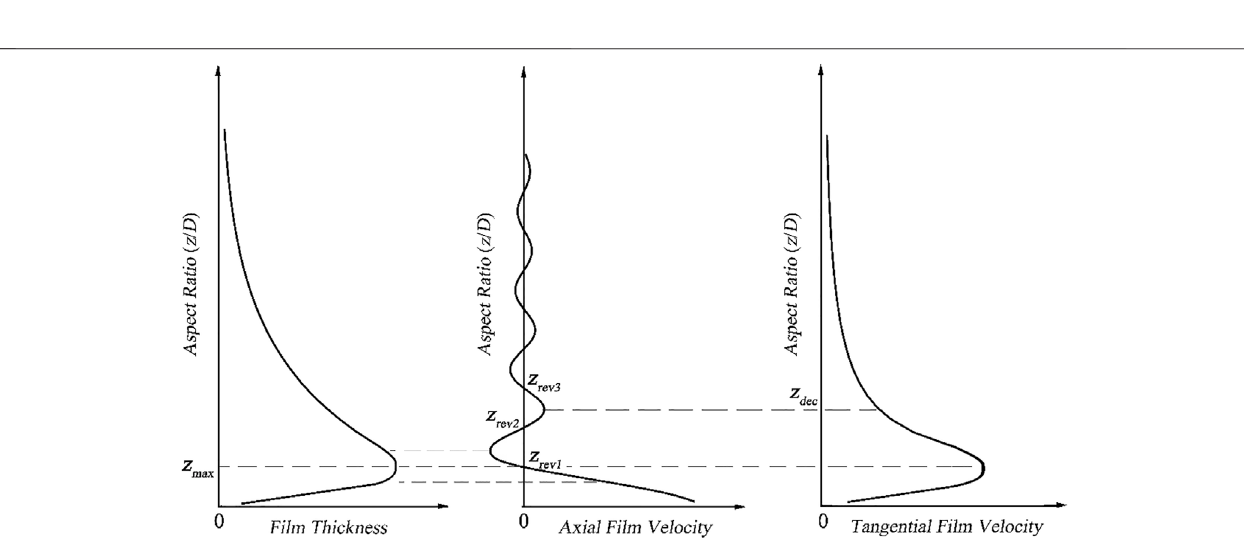
Frontiers in Chemical Engineering |